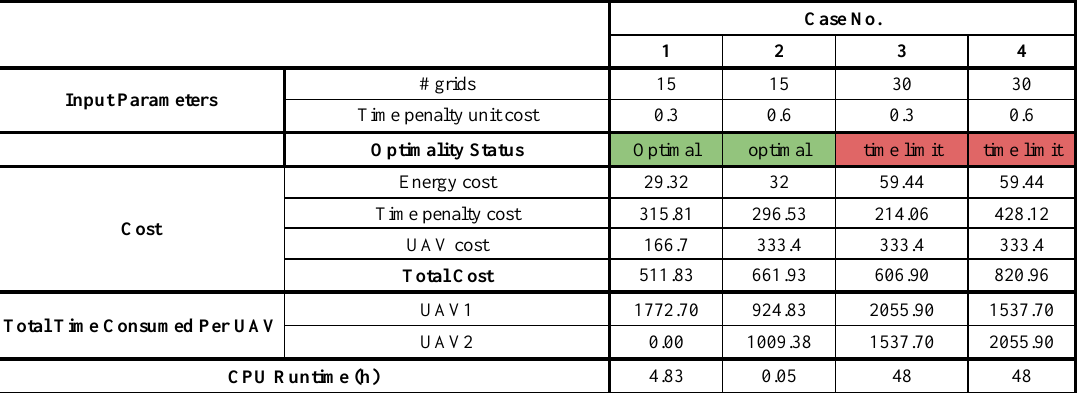
Table 8. Costs and runtimes on real terrain area.